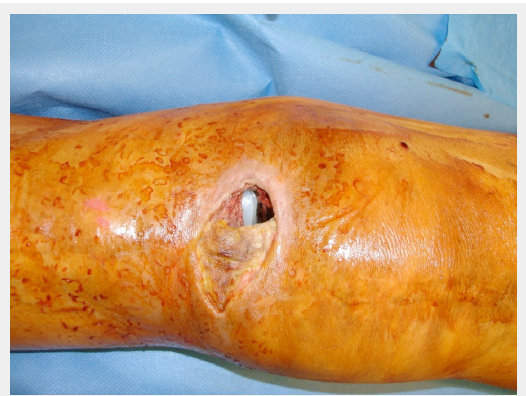
Cumulative revision rates (CRR) after total knee arthroplasty, with separate graphs for osteoarthritis (OA) and rheumatoid arthritis (RA). Reproduced with the kind permission of the Swedish Knee Arthroplasty Register.